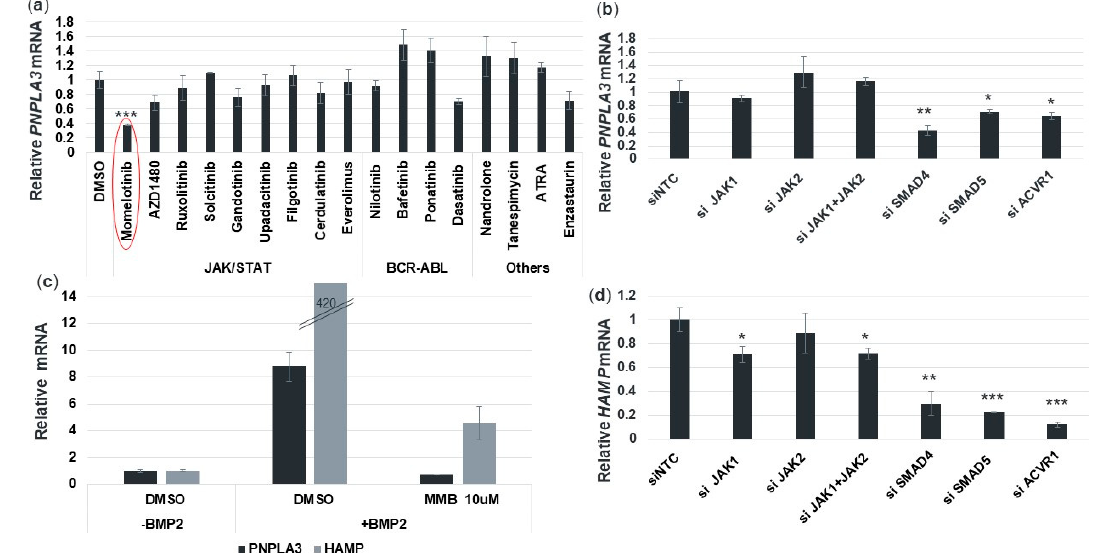
Figure 6. Momelotinib decreases PNPLA3 expression primarily through SMAD pathway inhibition.